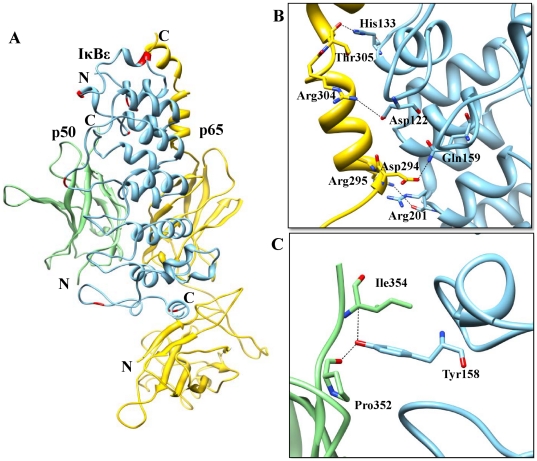
IκBε ARD-p65/p50 heterodimer interface.(A) The p50/p65 heterodimers represented as a ribbon diagram are shown in light green and yellow, respectively. Docked IκBε is represented in sky blue color in the ribbon diagram, and flexible residues involved in the interactions are in red color. (B) p65-IκBε binding interface. Side chains of the amino acids contributing to hydrogen bonding formation (marked as black dotted lines) are represented by a stick model with the residue names and numbers shown next to them. (C) p50-IκBε binding interface is also represented in a similar fashion as (B).